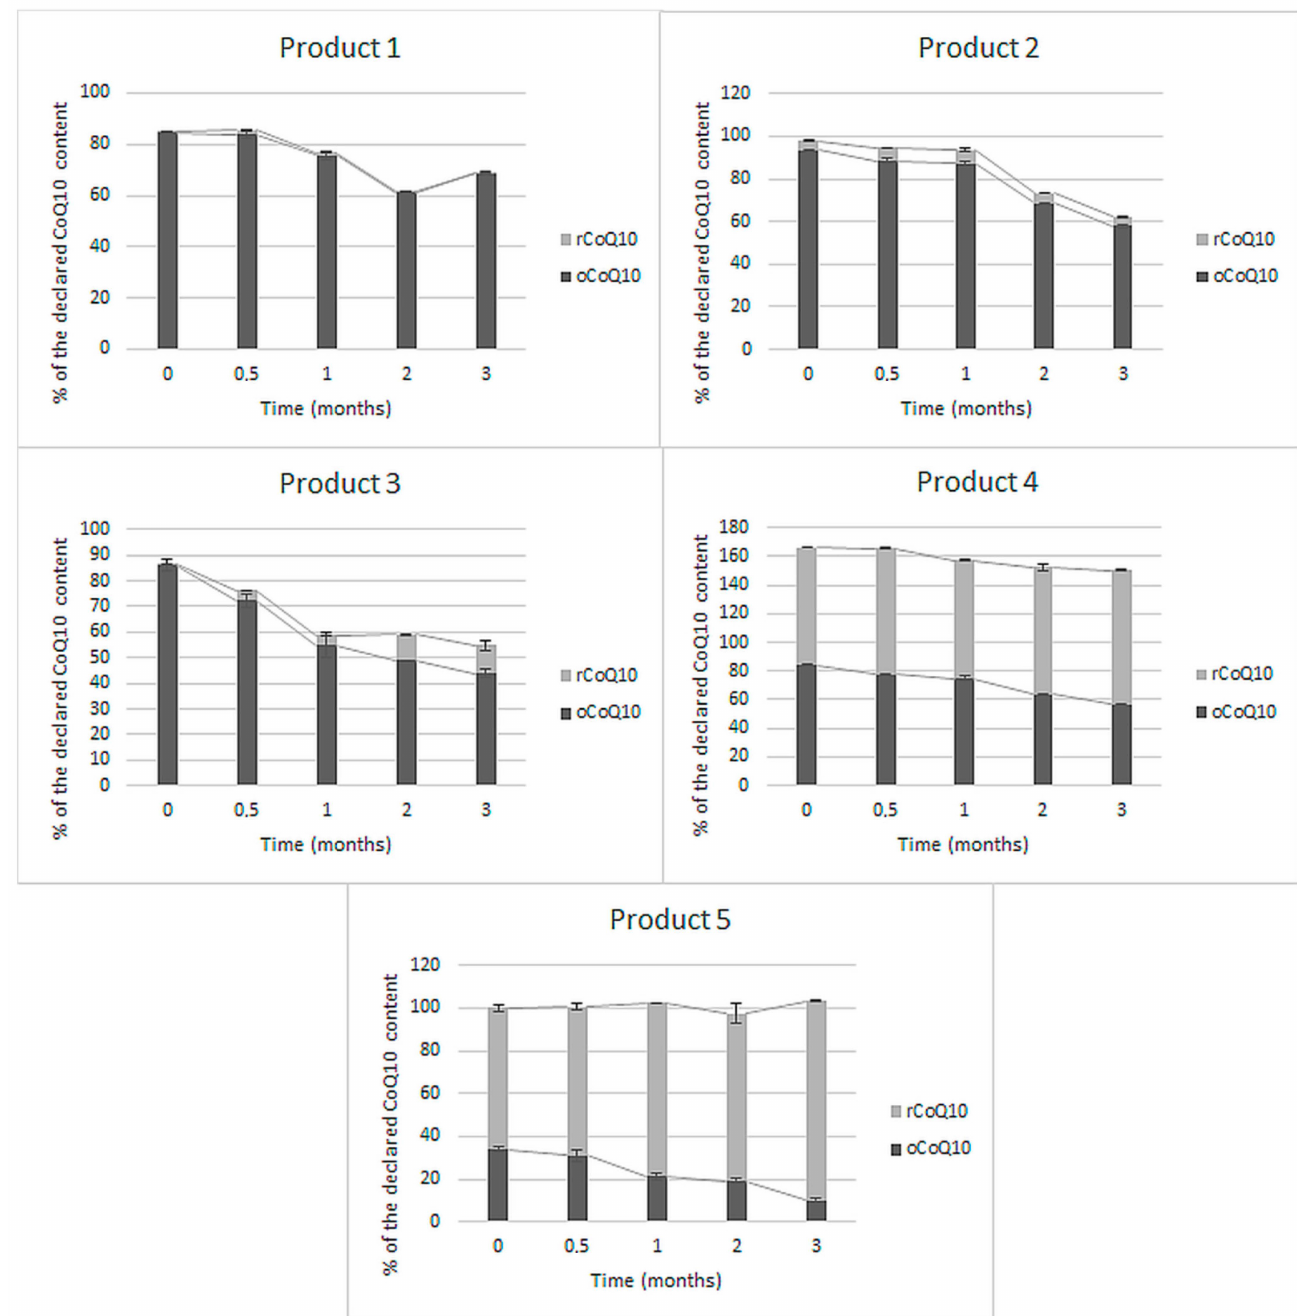
Figure 1. The stability of rCoQ10, oCoQ10, and total CoQ10 in the five tested finished products with undefined CoQ10 form after the accelerated stability